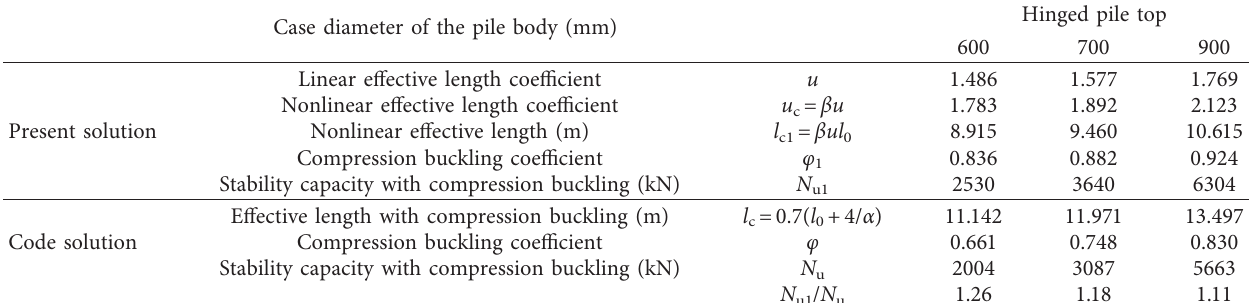
Table 2: Comparison of the bearing capacity with the compression buckling